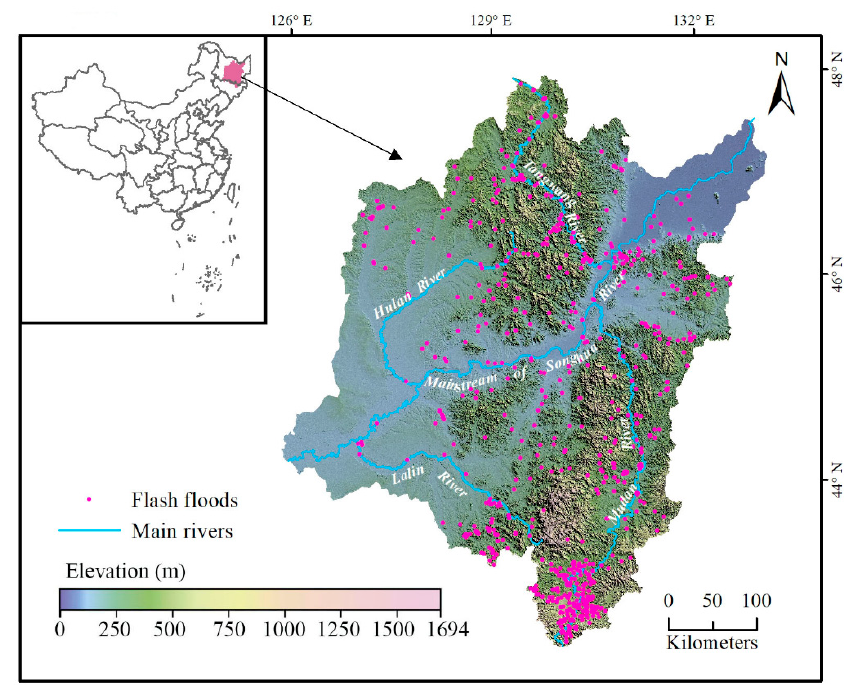
Figure 1. Location of the study area and distribution of the historical flash flood records.